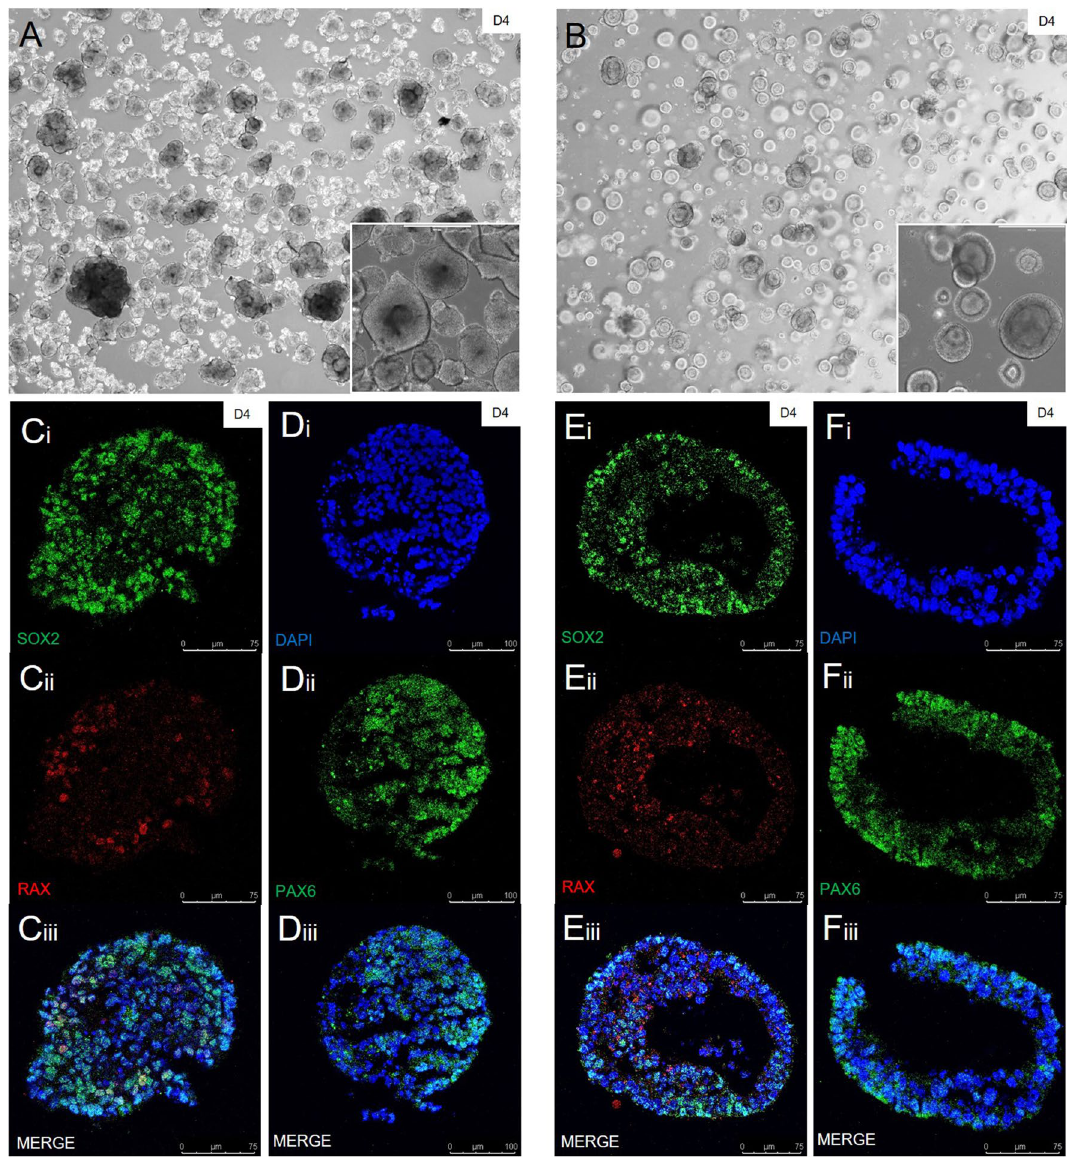
Figure 2. Differences between EBs grown in matrigel embedment (MG) culture vs floating suspension (FF) culture. ( A , B ) Under a light microscope, EBs grown using a floating culture technique ( A ) look morphologically unorganised when compared to EBs grown using matrigel 3D embedment culture technique ( B ) by day 4. Highly reproducible, this morphological difference (detailed in ( A , B ) inserts, scale bar = 400 µm) is clear to see throughout entire cultures. This is also evident when looking at cross sections using IHC. ( C – F ) Floating cultures generate a mass of cells, whereas the EBs cultured in matrigel drops possess a clear stratified layer of cells with a hollow centre, much like an already matured organoid, while also staying within the neural lineage. The acquisition of neural identity was confirmed in both the floating culture derived bodies ( Ci-iii , Di-iii ), as well as the matrigel derived bodies ( Ei-iii , Fi-iii ) using common neuronal markers SOX2 and PAX6 (both in green). The general retinal marker RAX (in red) was also confirmed in both sets of